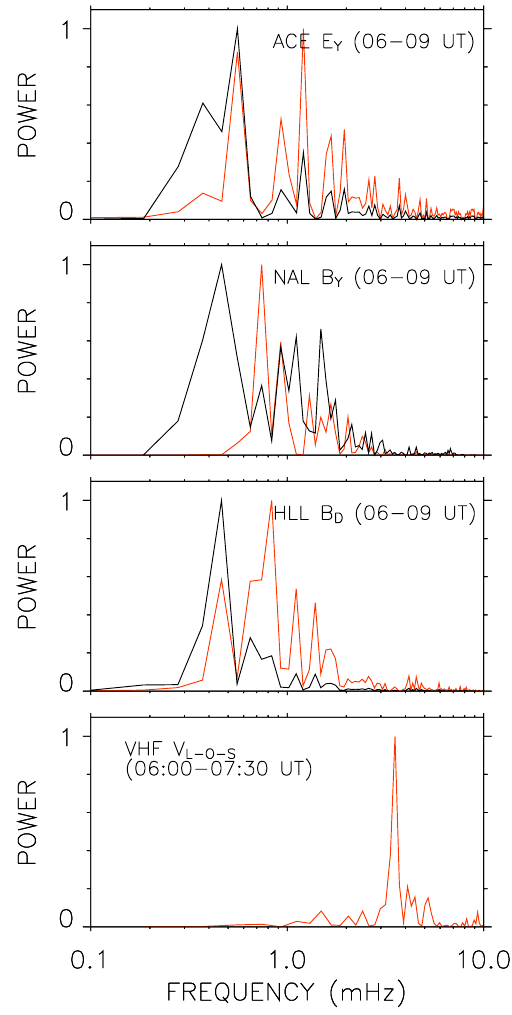
Fig. 13. Normalised frequency spectra showing oscillations with periodicity less that 3600s (black trace) and 1800s (red trace) in the dawn-dusk electric field measured at ACE, the east-west component of the magnetic field measured at the Ny Ålesund (NAL) and Hella (HLL) ground magnetometers, and the l-o-s ion velocity measured at 72 ◦ magnetic latitude by the VHF EISCAT